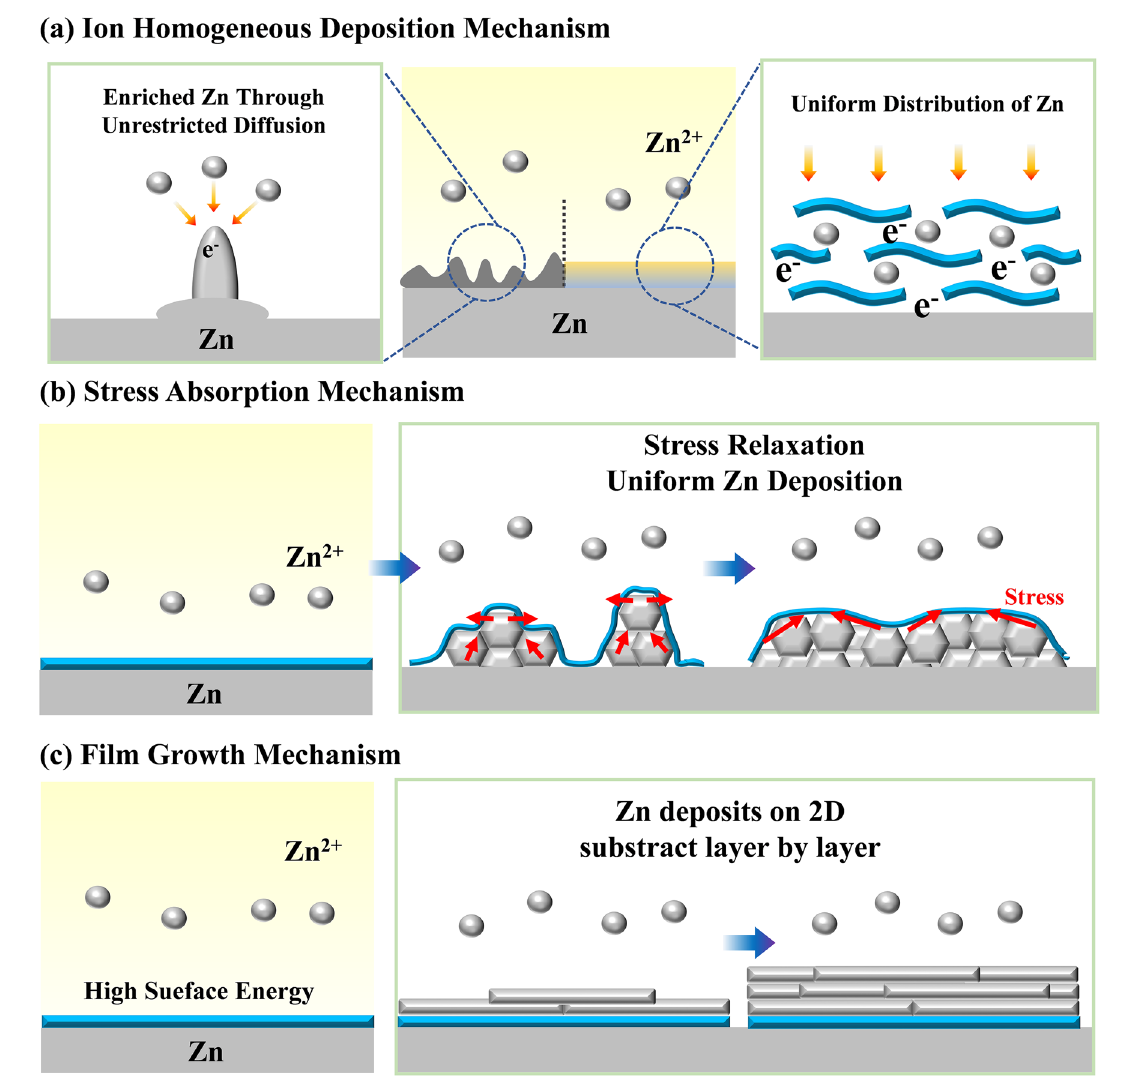
Fig. 2 Protective mechanisms of Zn anode based on 2D materials. a The interphase formed by 2D materials has high conductivities of electron and ion, which successfully disperse particles to reduce the concentration polarization and postpone the dendrite occurrence. b Protective layer with high mechanical strength can efficiently release the stress generated during Zn deposition process. c 2D-nanosheets-formed interphase with higher surface energy makes Zn inclined to deposit on substrate layer by layer